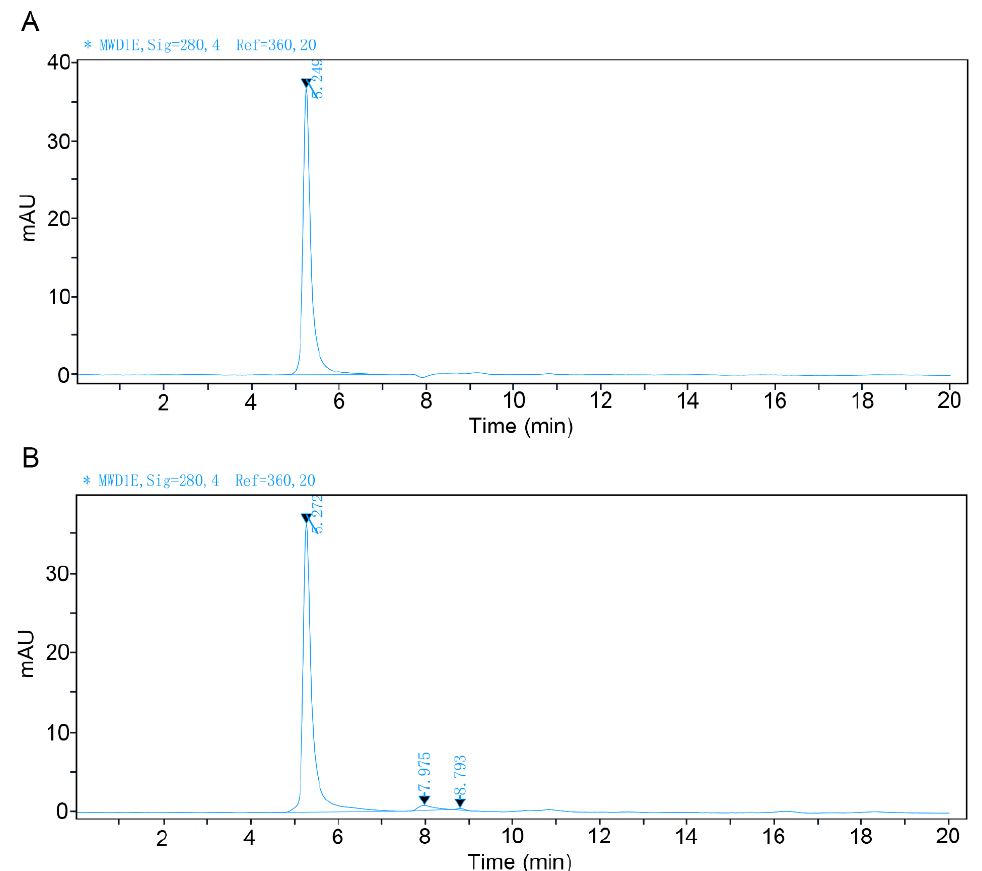
Figure 3. SEC ‐ HPLC analysis results of the recombinant VP1/VP2 and VP1h/VP2 VLPs after purifi ‐ Figure 3. SEC-HPLC analysis results of the recombinant VP1/VP2 and VP1h/VP2 VLPs after purifi- cation. ( A ): SEC ‐ HPLC analysis of the VP1/VP2 VLP. ( B ): SEC ‐ HPLC analysis of the VP1h/VP2 VLP. cation. ( A ): SEC-HPLC analysis of the VP1/VP2 VLP. ( B ): SEC-HPLC analysis of the VP1h/VP2